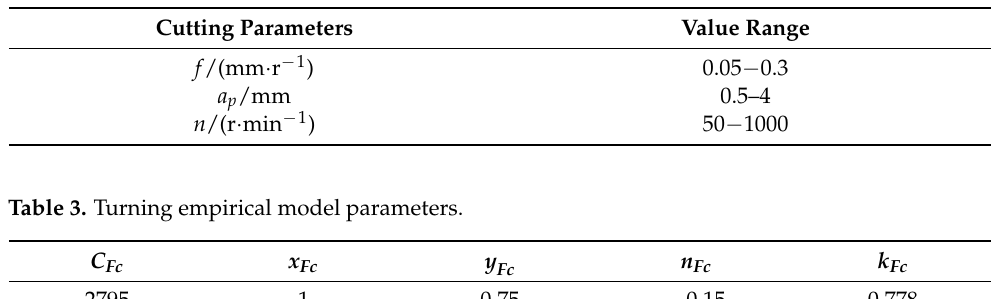
Table 2. Selection range of cutting parameters.